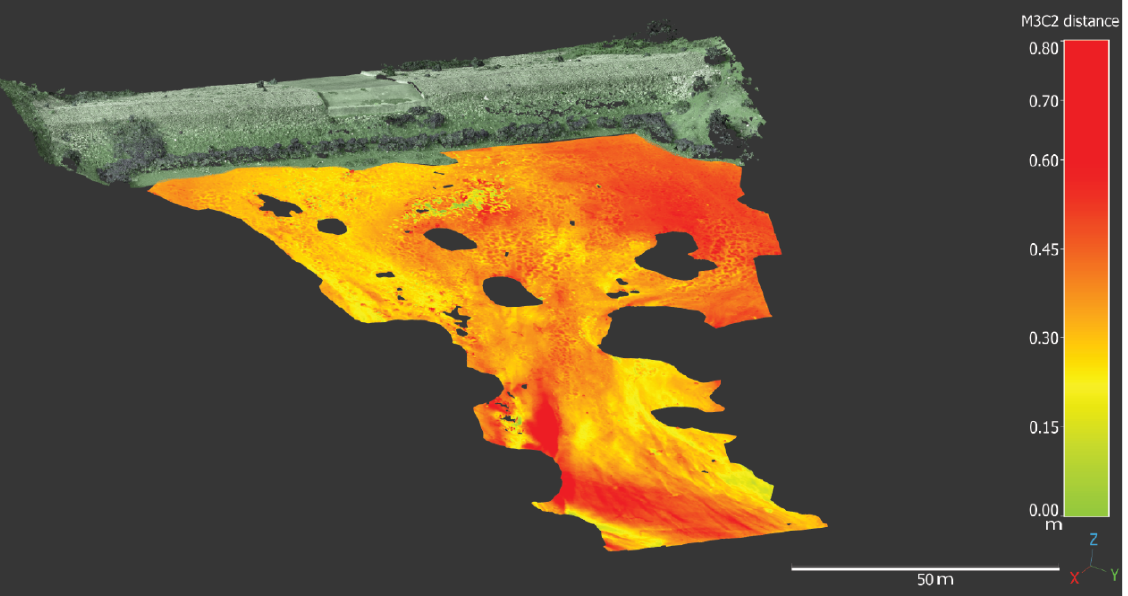
Figure 9. Annual topsoil vertical difference estimated using the M 3 C 2 algorithm application (2021–2022).